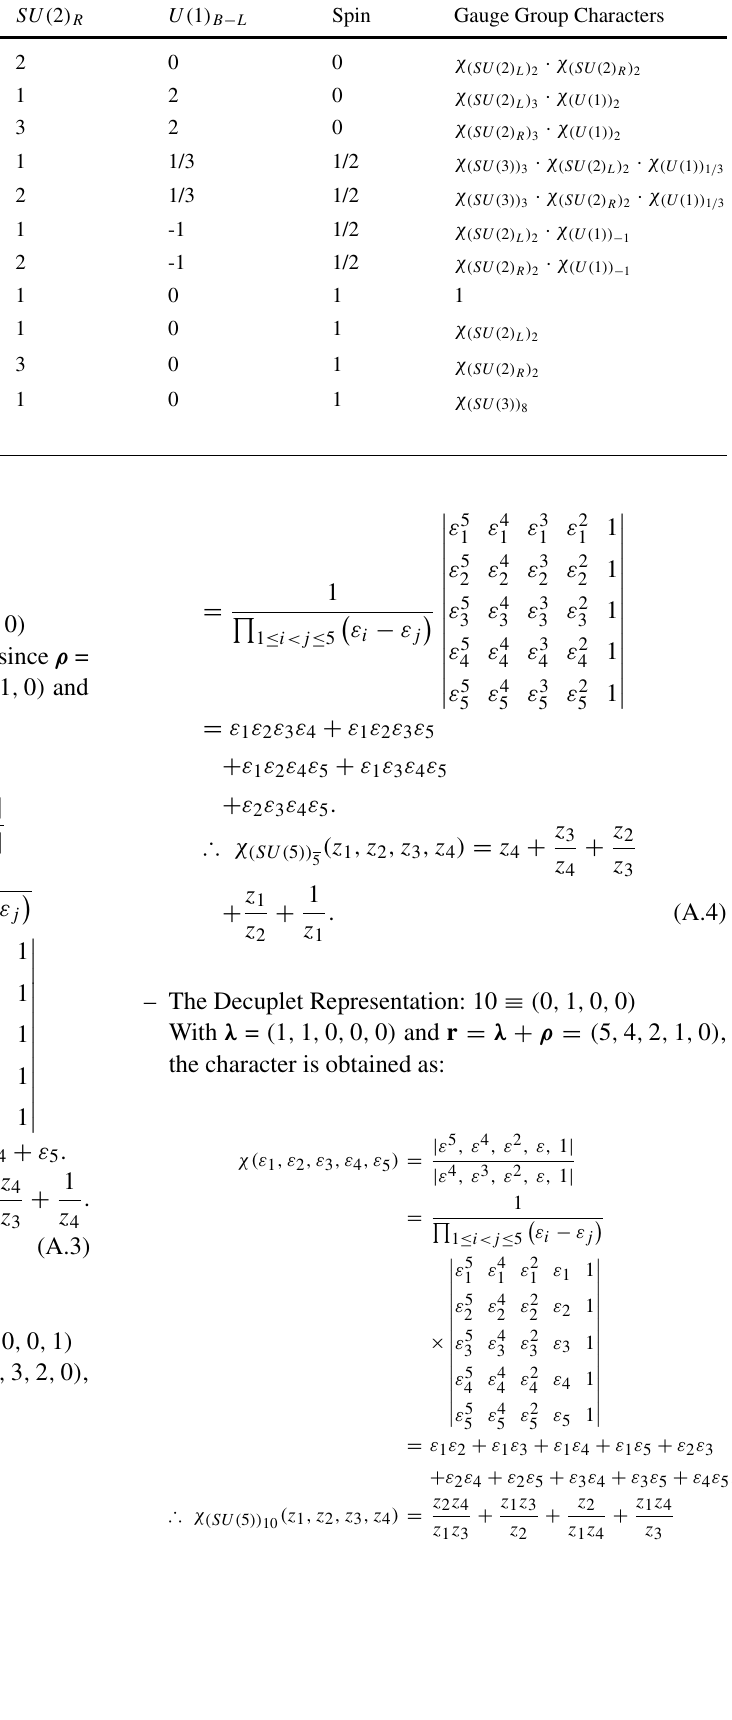
Table 46 MLRSM: Quantum numbers of fields under the gauge groups, their spins and gauge group characters. Since MLRSM only contains fields with spins-0, -1 / 2, and -1, the relevant Lorentz char- acters are the ones given in Eq. (109). Here, x parametrizes the U ( 1 )